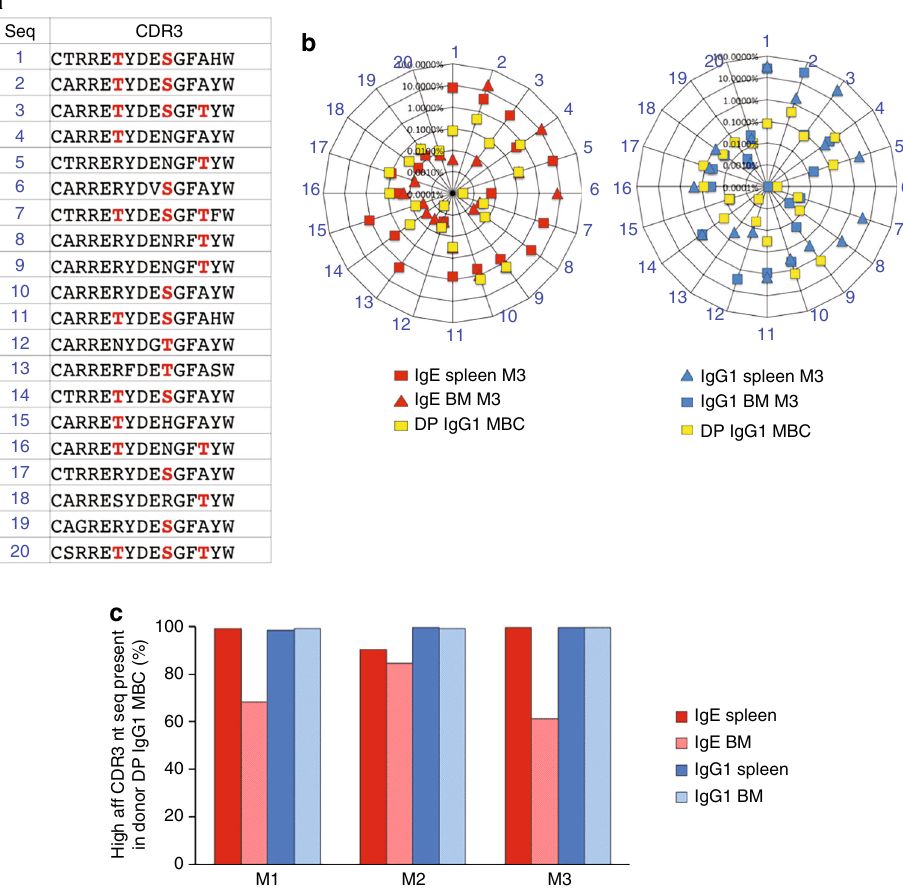
Fig. 4 High af fi nity PC are selected from pre-existent memory clones. The repertoires of VDJ sequences from donor IgG1 MBC subsets (from 10 weeks OVA-PEP1 immunised TBmc mice) and their IgG1 and IgE progenies in spleen and BM of recipient mice (2 weeks after transfer/immunisation), were used to investigate the precursor-progeny relationship. a In silico derived sublibrary of the top 20 (frequency descending) VDJ CDR3 aa sequences containing high af fi nity mutations (in red ). b Radar charts show the presence and frequency of each of the top 20 high af fi nity CDR3 sequences in donor DP IgG1 MBC and in the progeny IgE ( left ) and IgG1 ( right ) libraries. a , b The data are from one representative mouse of three recipient mice. c Percentage of the progeny IgE and IgG1 nucleotide sequences (nt seq) encoding high af fi nity CDR3 that were found in the donor DP IgG1 MBC. M1 – M3 indicate